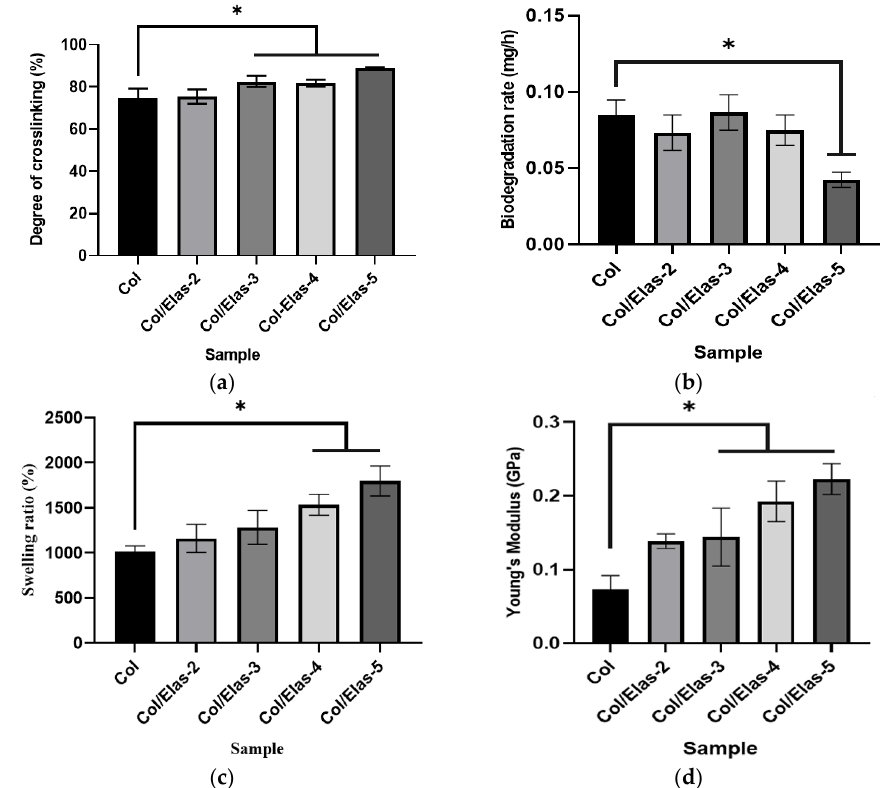
Figure 2. ( a ) The degree of crosslinking of Col/Elas sca ff olds crosslinked by 0.1% genipin. ( b ) The enzymatic degradation of Col/Elas sca ff olds in 0.0006% collagenase at 37 °C. ( c ) The water absorption capacity (%) of Col/Elas sca ff olds. ( d ) Young’s modulus of Col/Elas sca ff olds . (*) represents a signi fi cant di ff erence ( p < 0.05; n = 3) between fabricated sca ff olds.